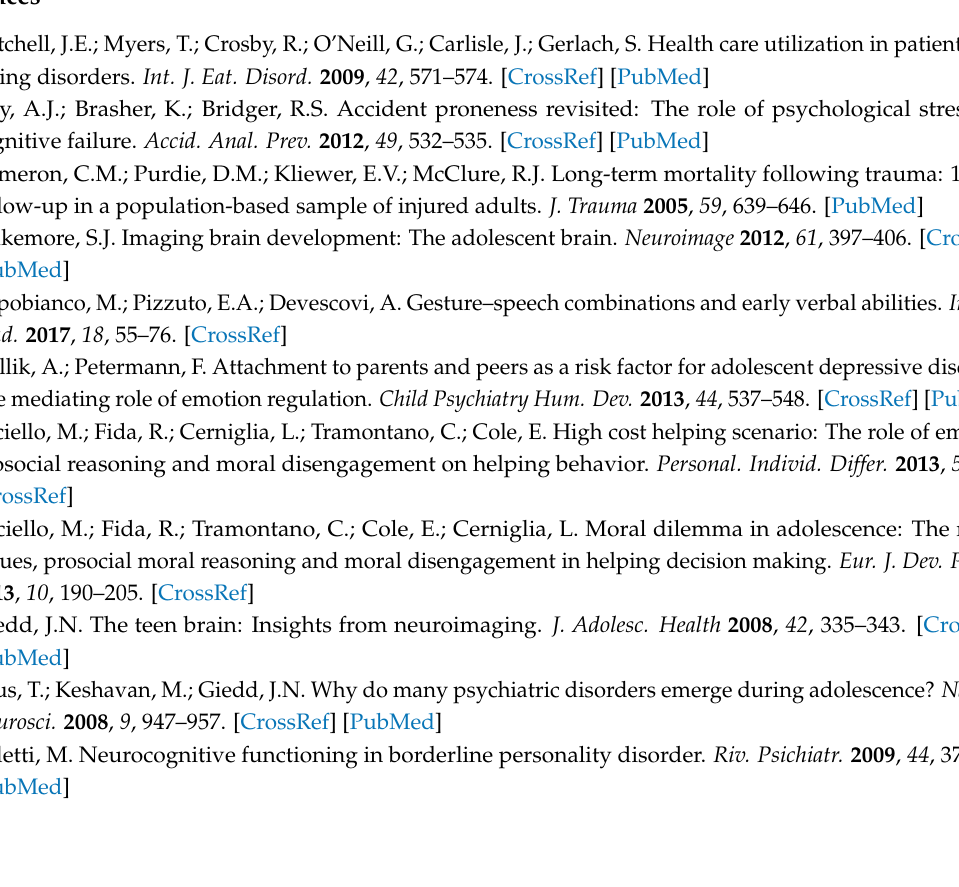
Table S1: Comparison between binge-eating and non-binge-eating